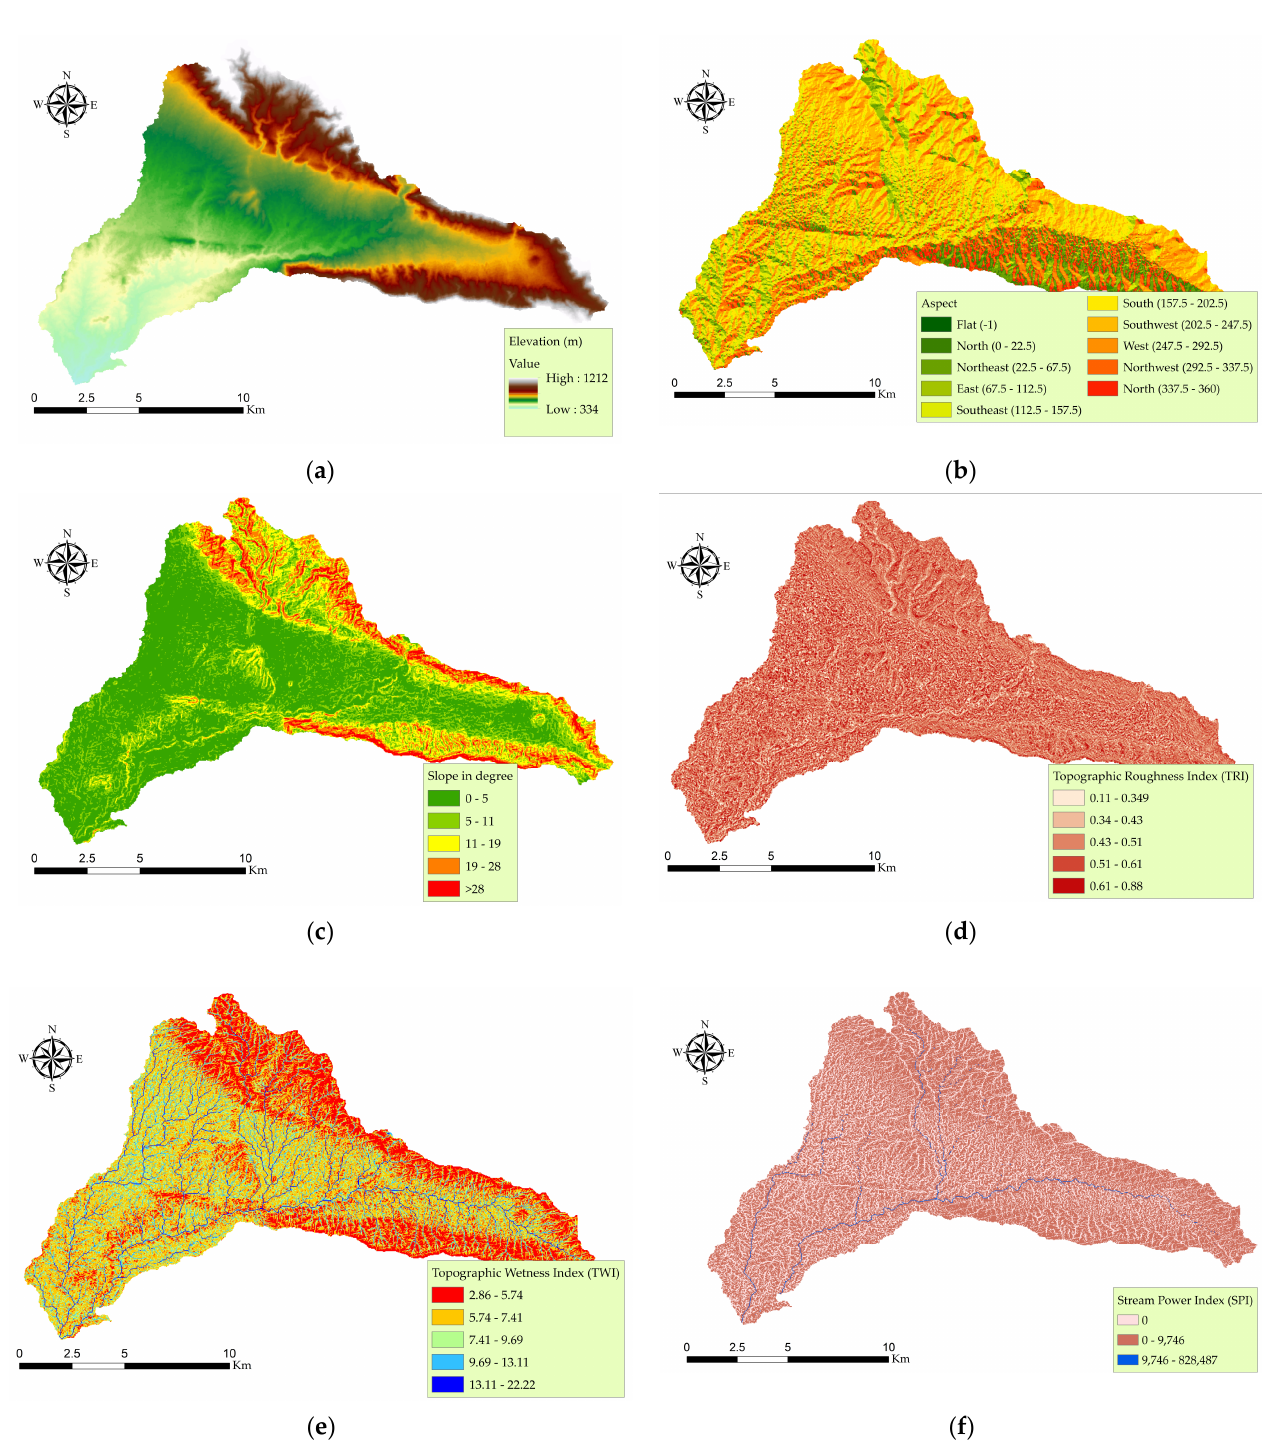
Figure 2. Thematic layers: ( a ) Elevation, ( b ) Aspect, ( c ) Slope, ( d ) Topographic Roughness Index, ( e ) Topographic Wetness Index, ( f ) Stream Power Index.